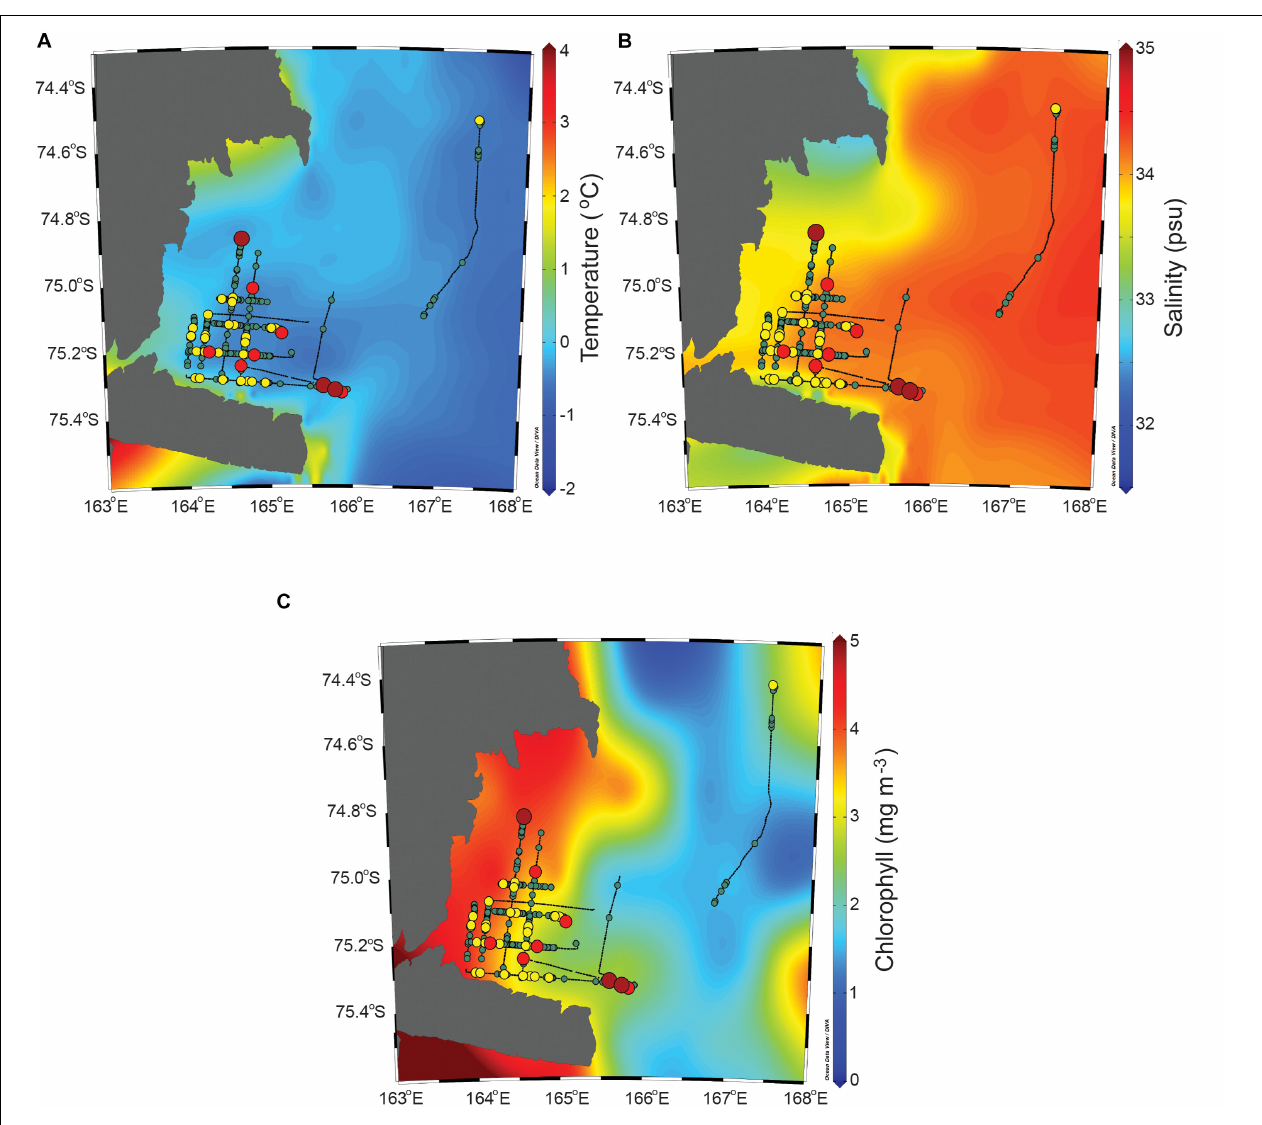
FIGURE 5 | The interpolated water temperature, salinity, and chlorophyll along with the horizontal distribution of the krill NASC values. The legend of NASC is the same as that in Figure 4